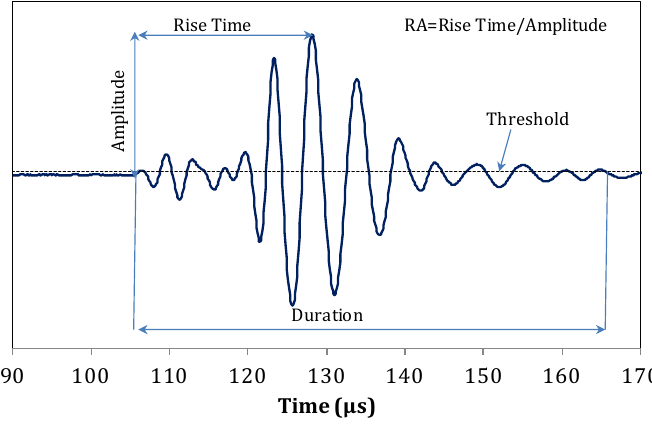
Figure 11. ( a ) RA, ( b ) CF and ( c ) AF of waveforms at different sensors on femur and